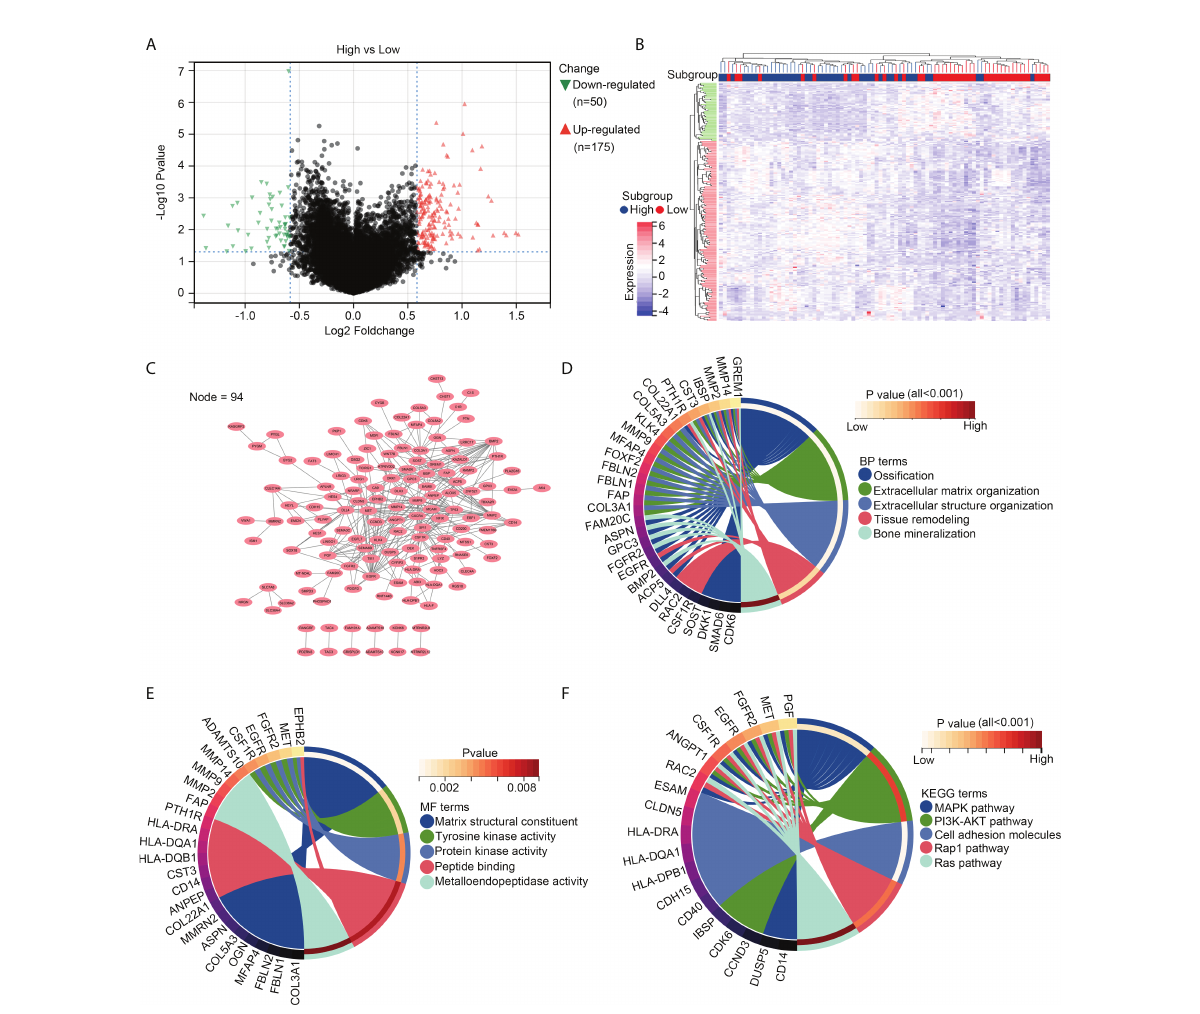
FIGURE 2 Genetic characterization of OS tissues with high in fi ltration of resting dendritic cells. (A) Volcano plot exhibiting the upregulated and downregulated genes in OS tissues between groups with high and low in fi ltration of resting dendritic cells. (B) Heatmap plot exhibiting the upregulated and downregulated genes in OS tissues between groups with high and low in fi ltration of resting dendritic cells. (C) PPI network indicating the relationship between the 94 genes associated with the in fi ltration of resting dendritic cells. (D) Biological process analyses for the 94 genes associated with the in fi ltration of resting dendritic cells. (E) Molecular function analyses for the 94 genes associated with the in fi ltration of resting dendritic cells. (F) KEGG analysis for the 94 genes associated with the in fi ltration of resting dendritic